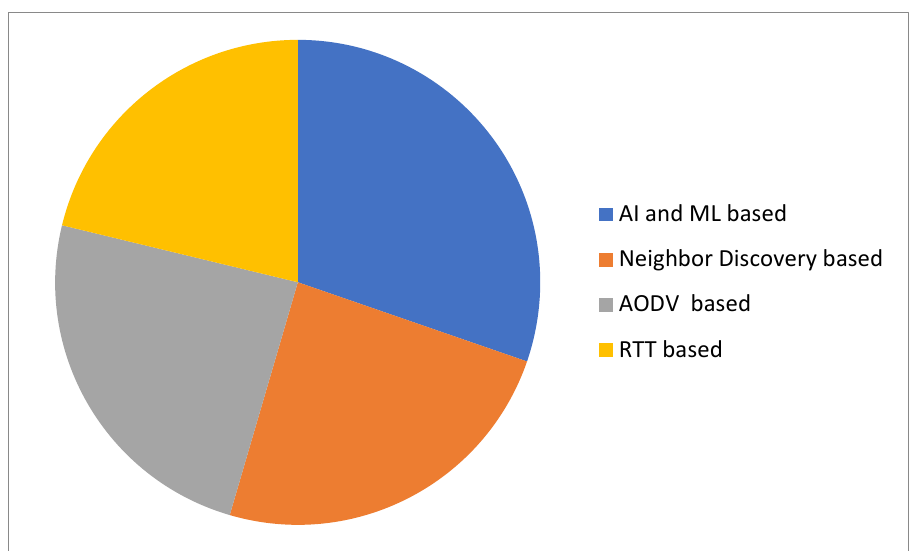
Figure 7. Analysis of the accuracy of AI- and ML-based schemes in comparison to other schemes.